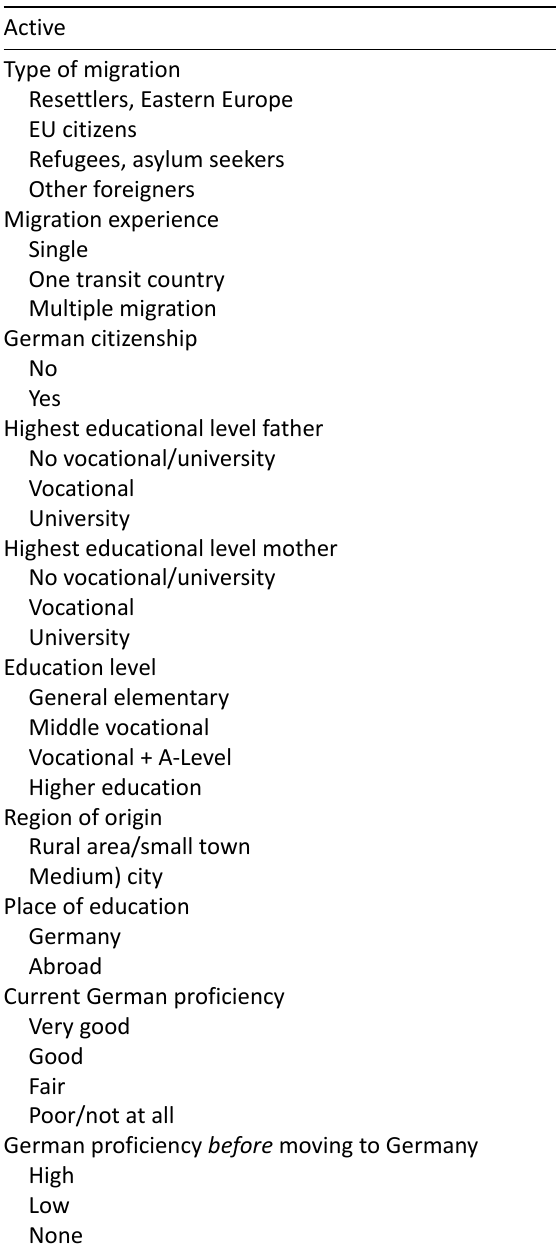
Table 1. Variables included in